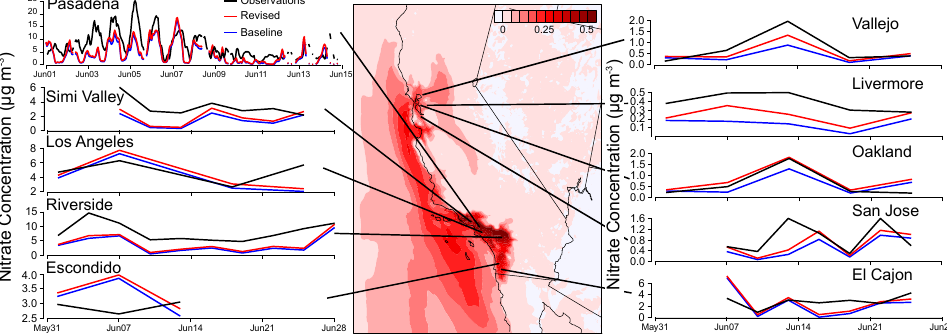
Figure 6. Change (µgm − 3 ) in the fine-mode (Aitken + accumulation) surface nitrate concentration between the revised and baseline sim- ulations for June 2010 over the CalNex domain surrounded by time series plots of the observed and predicted daily and/or hourly PM 2 . 5 nitrate concentration at the coastal CalNex sites.